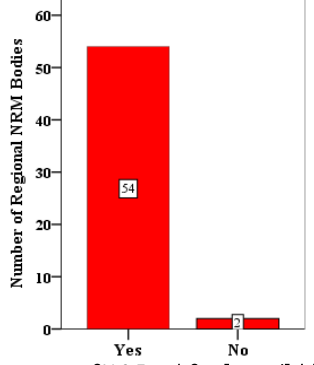
Figure 5. Breakdown of user/provider of spatial information